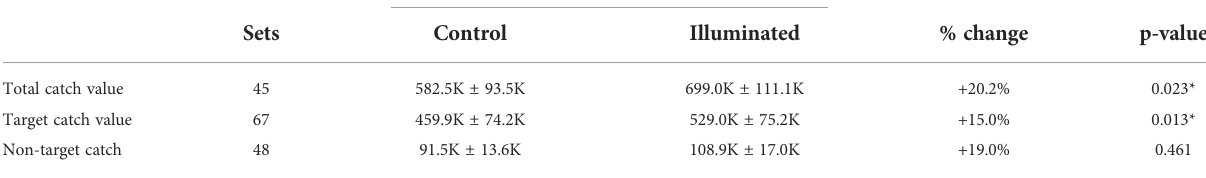
TABLE 4 Comparison of the mean market value per unit effort (MVPUE, value in thousands (K) of Indonesian rupiah, SE=standard error) between control and illuminated net treatment for the total market value of the catch, the target catch ( Parastromateus niger, Pampus argenteus, and Pampus chinensis ), and commercially valuable retained non-target